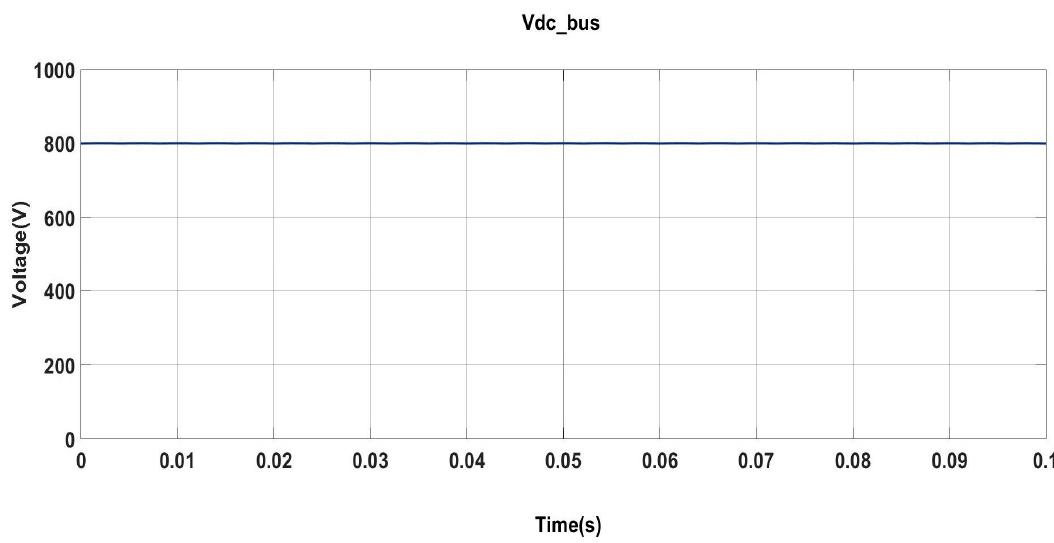
Figure 7. The voltage of the common DC bus.